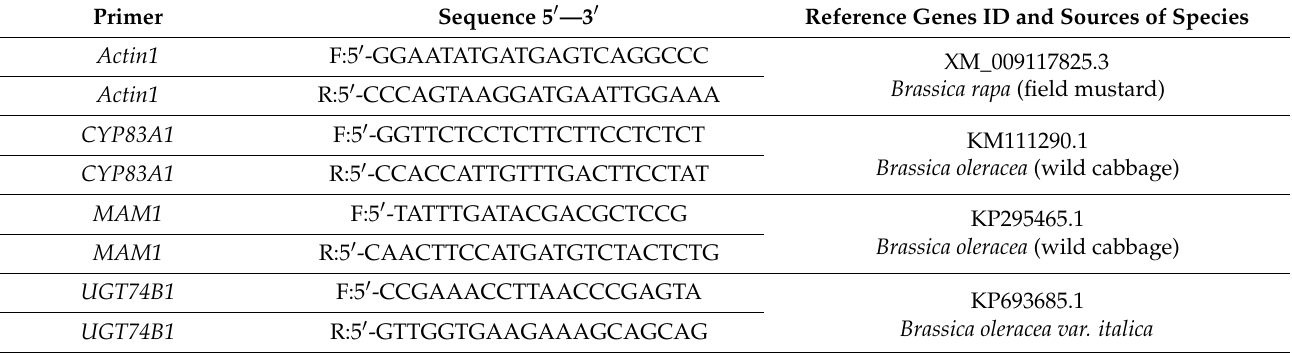
Table 2. Primers used in qRT-PCR